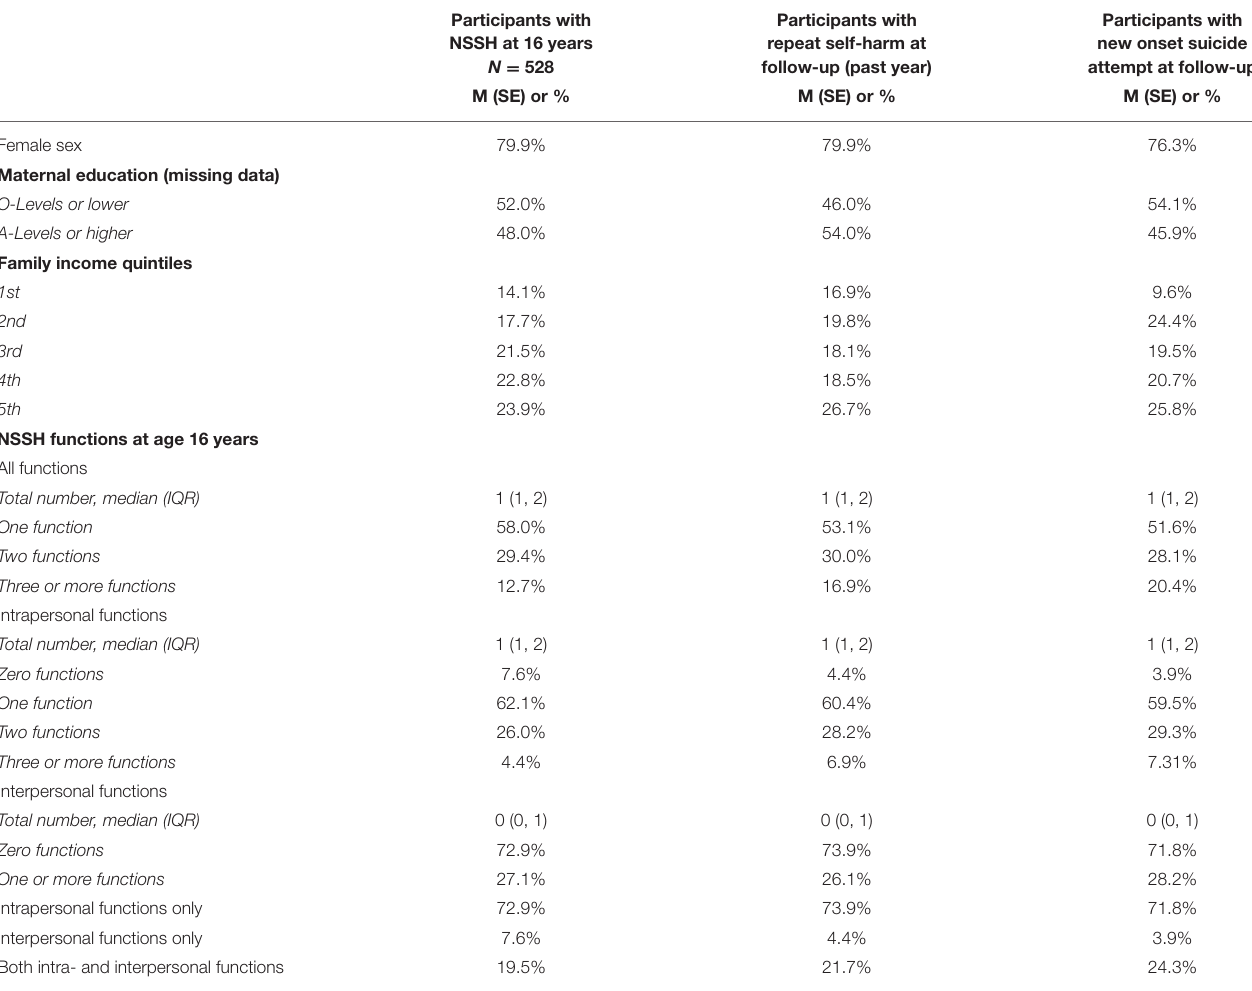
TABLE 3 | Sociodemographic and NSSH function characteristics at baseline according to self-harm outcome: imputed